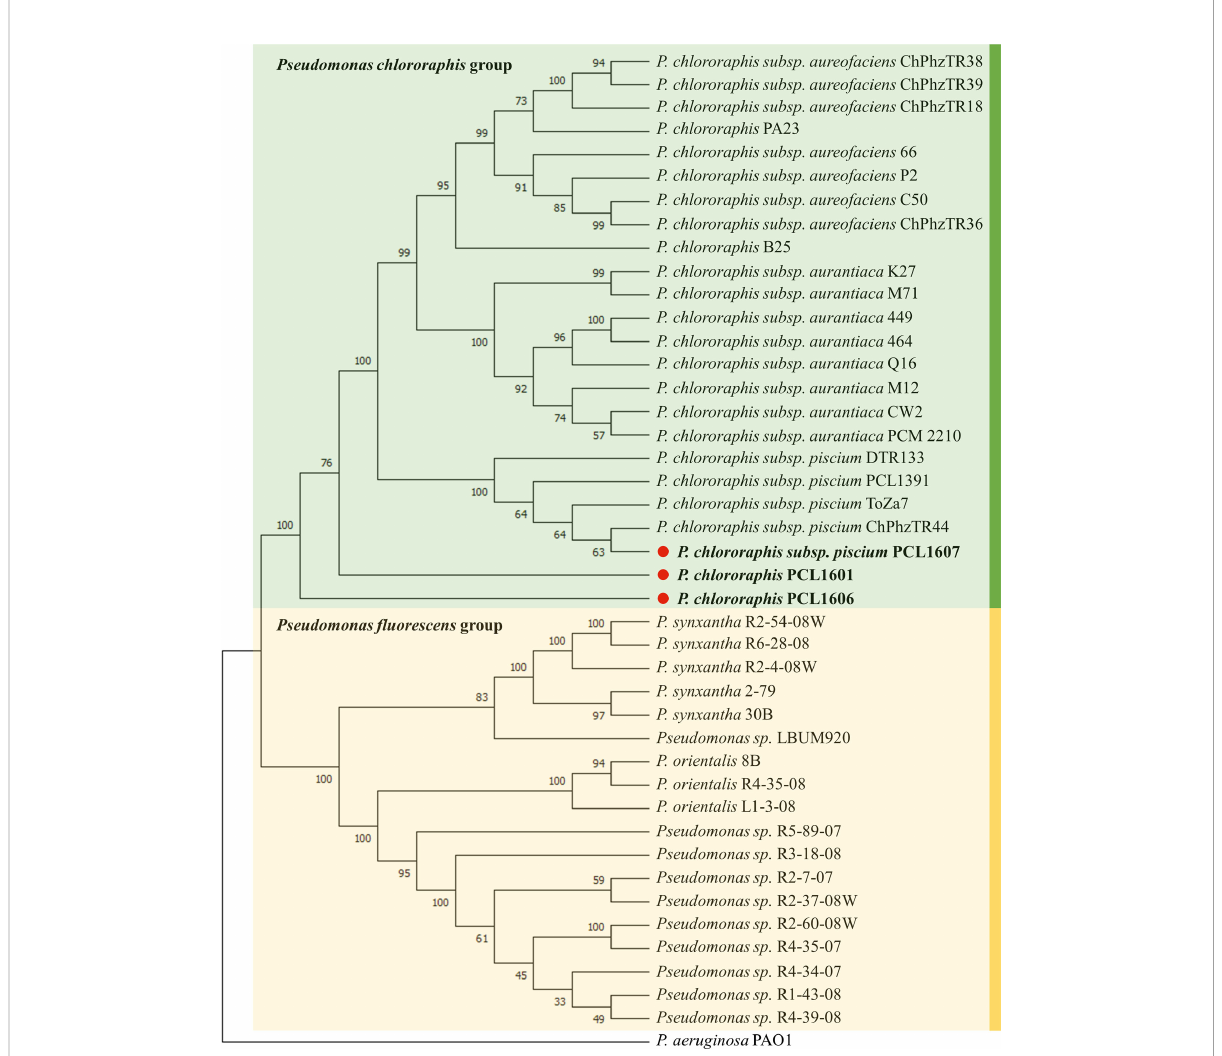
FIGURE 1 Rhizospheric Pseudomonas spp. phylogeny including Pc strains PCL1601, PCL1606 and PCL1607, marked with a red point and bold letters. Sequences were aligned by MUSCLE. The tree was made with MEGA 11 by multilocus sequence typing using concatenated 16S and the housekeeping genes rpoD , gyrB and recA . The neighbour-joining method with 1000 bootstraps and the Juke-Cantor model were used. The numbers in the nodes are the bootstrap values. P. aeruginosa PAO1 was used as an